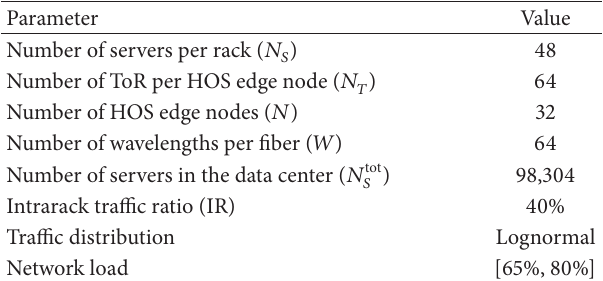
Table 2: Reference data center configuration.